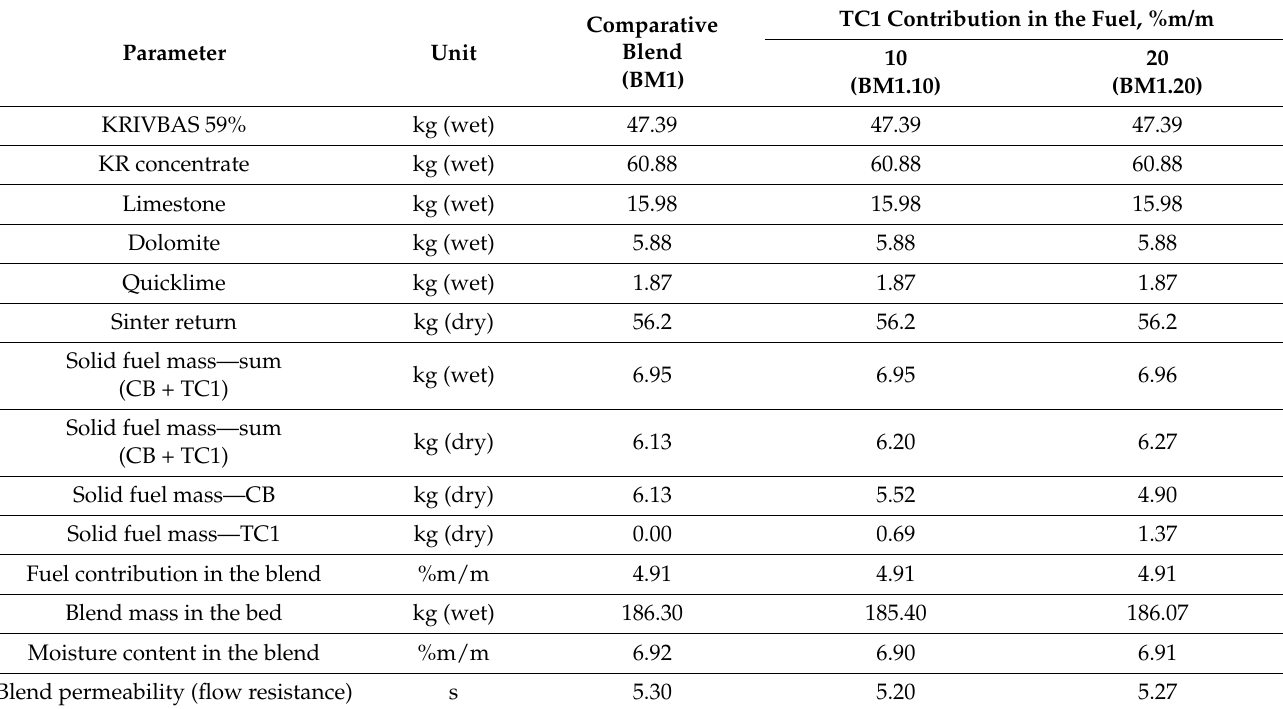
Table 4. Composition of sintering blends with and without TC1